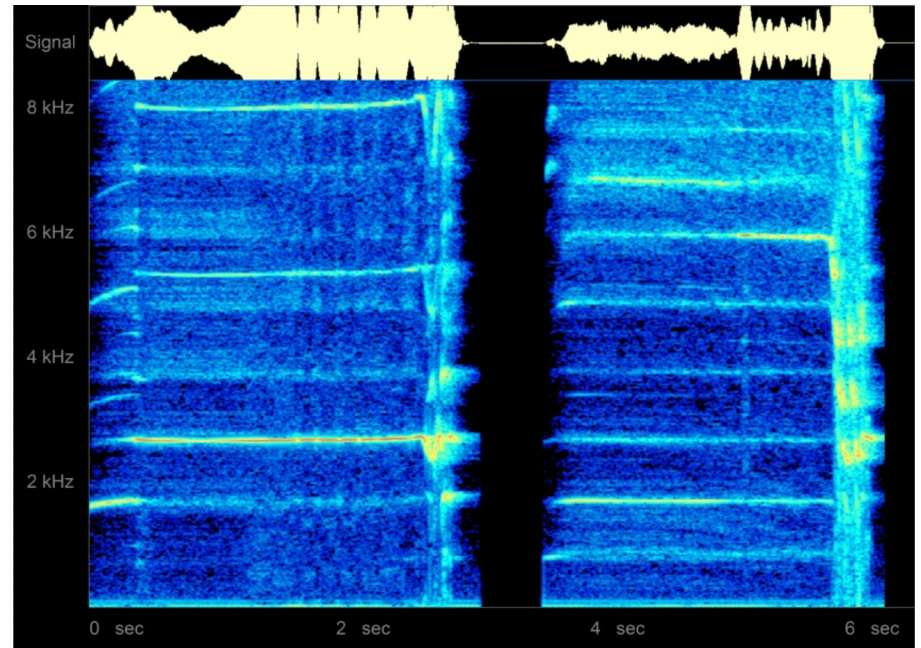
Figure 34. Spectrogram of piston whistle, experimental model, overblown, two movements, left (po- sition 1): upwards, ascending alternating glissando effect; right (position 2): downwards, descending glissando effect (Sample